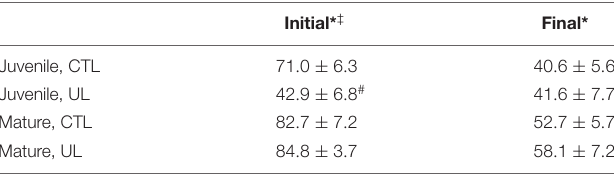
TABLE 6 | Effects of age (mature/juvenile) and treatment (control/unloaded) on neuromuscular transmission efficiency (%), at beginning (Initial) and conclusion (Final) of 5 min train of